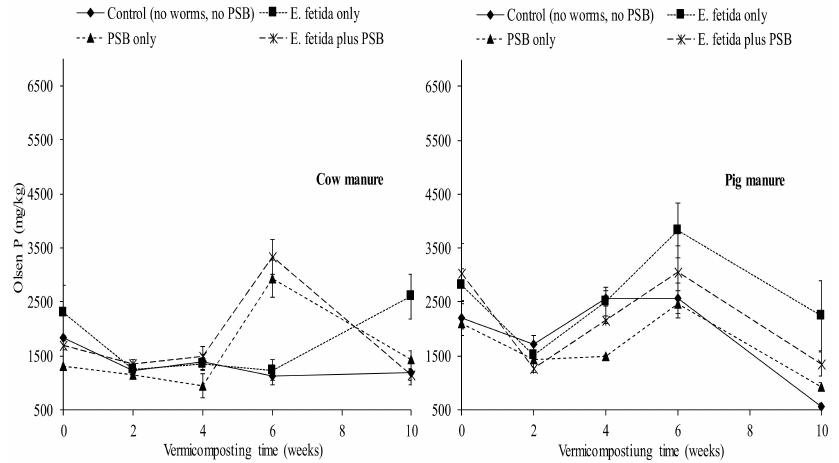
Figure 6. E ff ect of E. fetida and P. fluorescence on Olsen extractable P during vermicomposting of cow and pig manure amended with rock phosphate and P. fluorescence . Error bars indicate standard